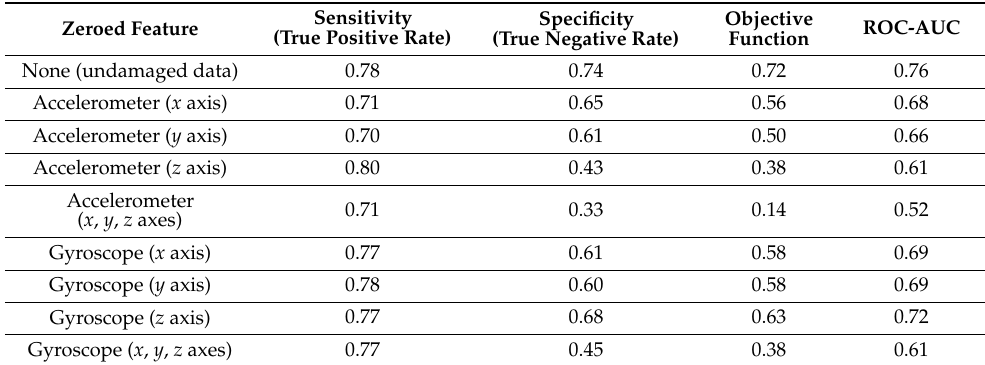
Table 2. The influence of sensor data damage on average model quality.